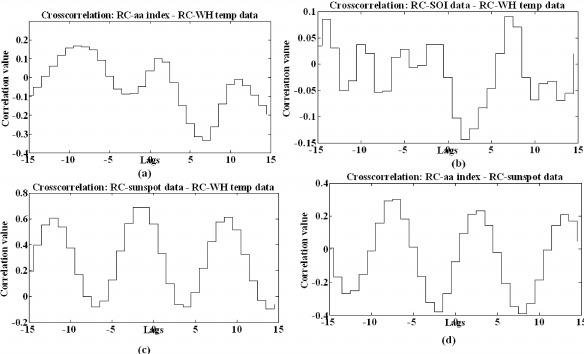
Figure 10. Cross-correlation of SSA reconstructed time series of (a) aa index–Western Himalayan (WH) temperature data, (b) SOI– WH temperature data, (c) sunspot–WH data, and (d) aa index– sunspot